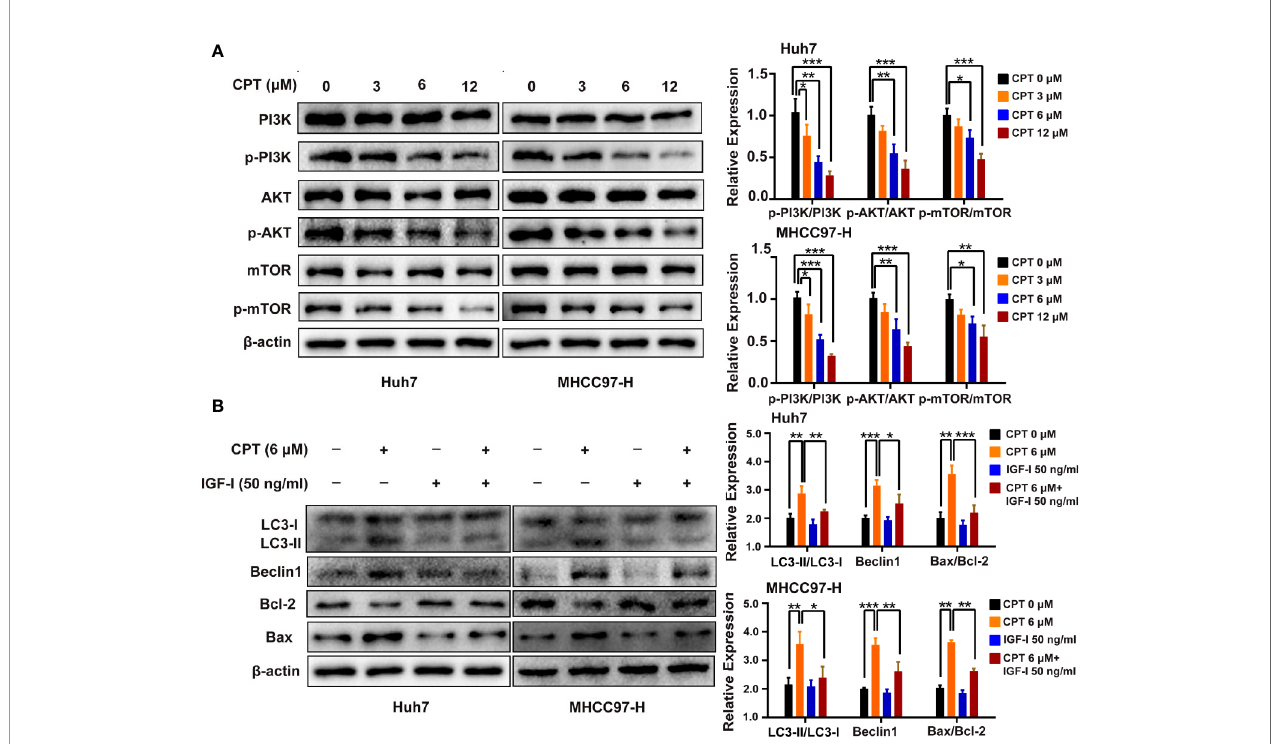
FIGURE 10 | Phosphatidylinositol 3-kinase (PI3K)/protein kinase B (Akt)/mammalian target of rapamycin (mTOR) signaling pathway is involved in cryptotanshinone (CPT)-induced autophagy and apoptosis. (A) Western blot analysis of PI3K, p-PI3K, AKT, p-AKT, mTOR, and p-mTOR in human hepatocellular carcinoma (HCC) cells treated with different doses of CPT (0, 3, 6, and 12 m M) for 24 h. * P < 0.05, ** P < 0.01, and *** P < 0.001 versus the control group. (B) HCC cells were exposed to 6 m M CPT alone or in combination with 50 ng/ml insulin-like growth factor-I (IGF-I). The expression levels of LC3-I, LC3-II, Beclin1, Bcl-2, and Bax proteins were assessed by western